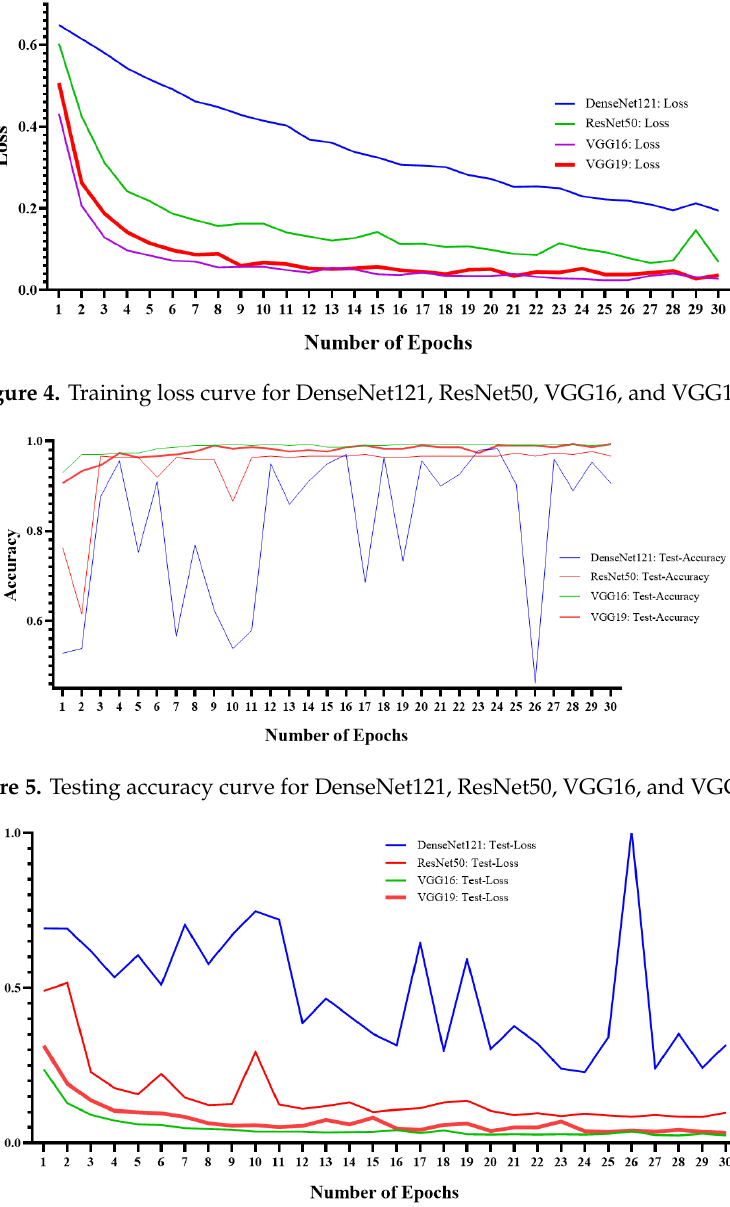
Figure 6. Testing loss curve for DenseNet121, ResNet50, VGG16, and VGG19.